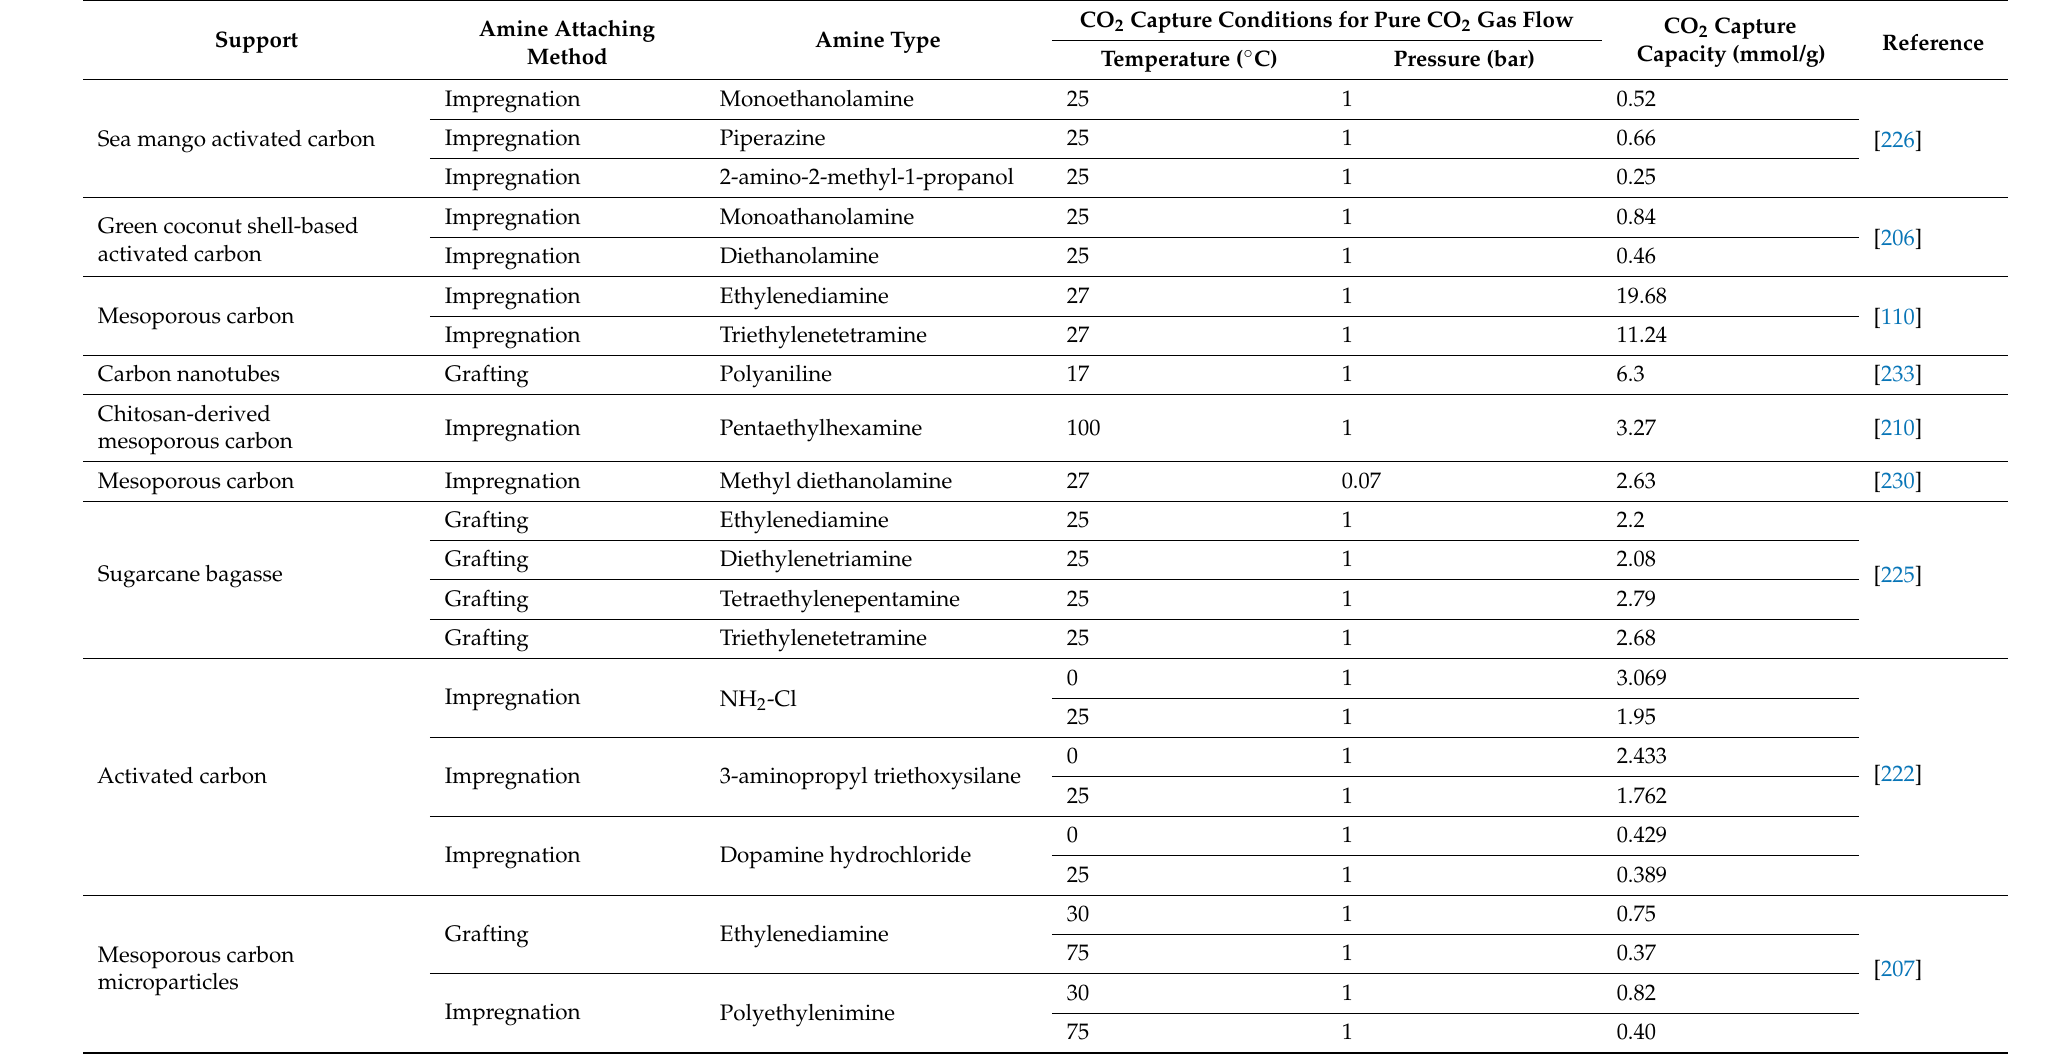
Table 11. CO 2 adsorption capacities of the amine-functionalized porous carbon